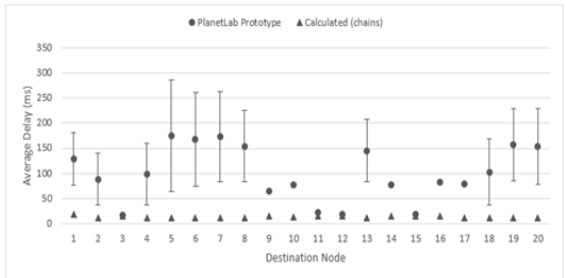
Fig. 8. Plot of Maximum Delay Variations VS Number of Destination Nodes